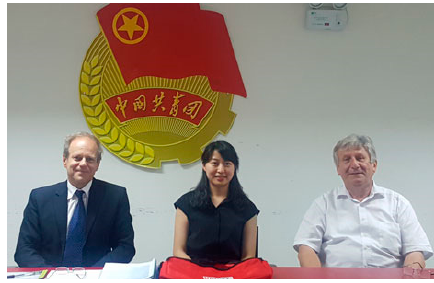
Figure 11. Peking University, Beijing, China, 25 May 2017. From left to right: Professor Gerhard Litscher, Eurasia Pacific Uninet (EPU) scholarship applicant, and Professor Wolf-Dieter Rausch, President of EPU. 26 May 2017: Capital Medical University (CMU): Beijing Hospital of TCM, Beijing, China.